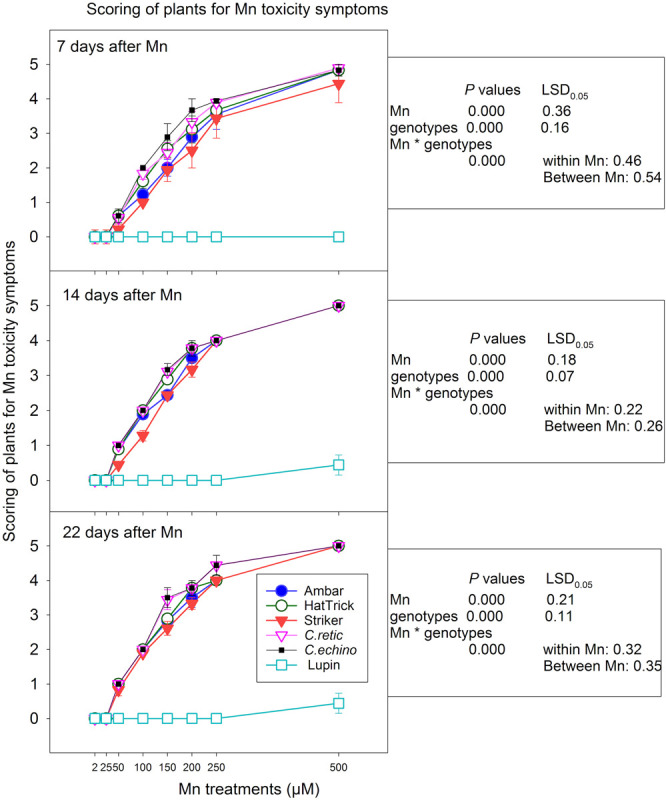
Scoring of Cicer genotypes and lupin for Mn toxicity symptoms at 7, 14, and 22 days after Mn additions. Vertical bars where visible represent the standard error of the mean. See Figure 1 for images of the symptoms for scores 0–5.